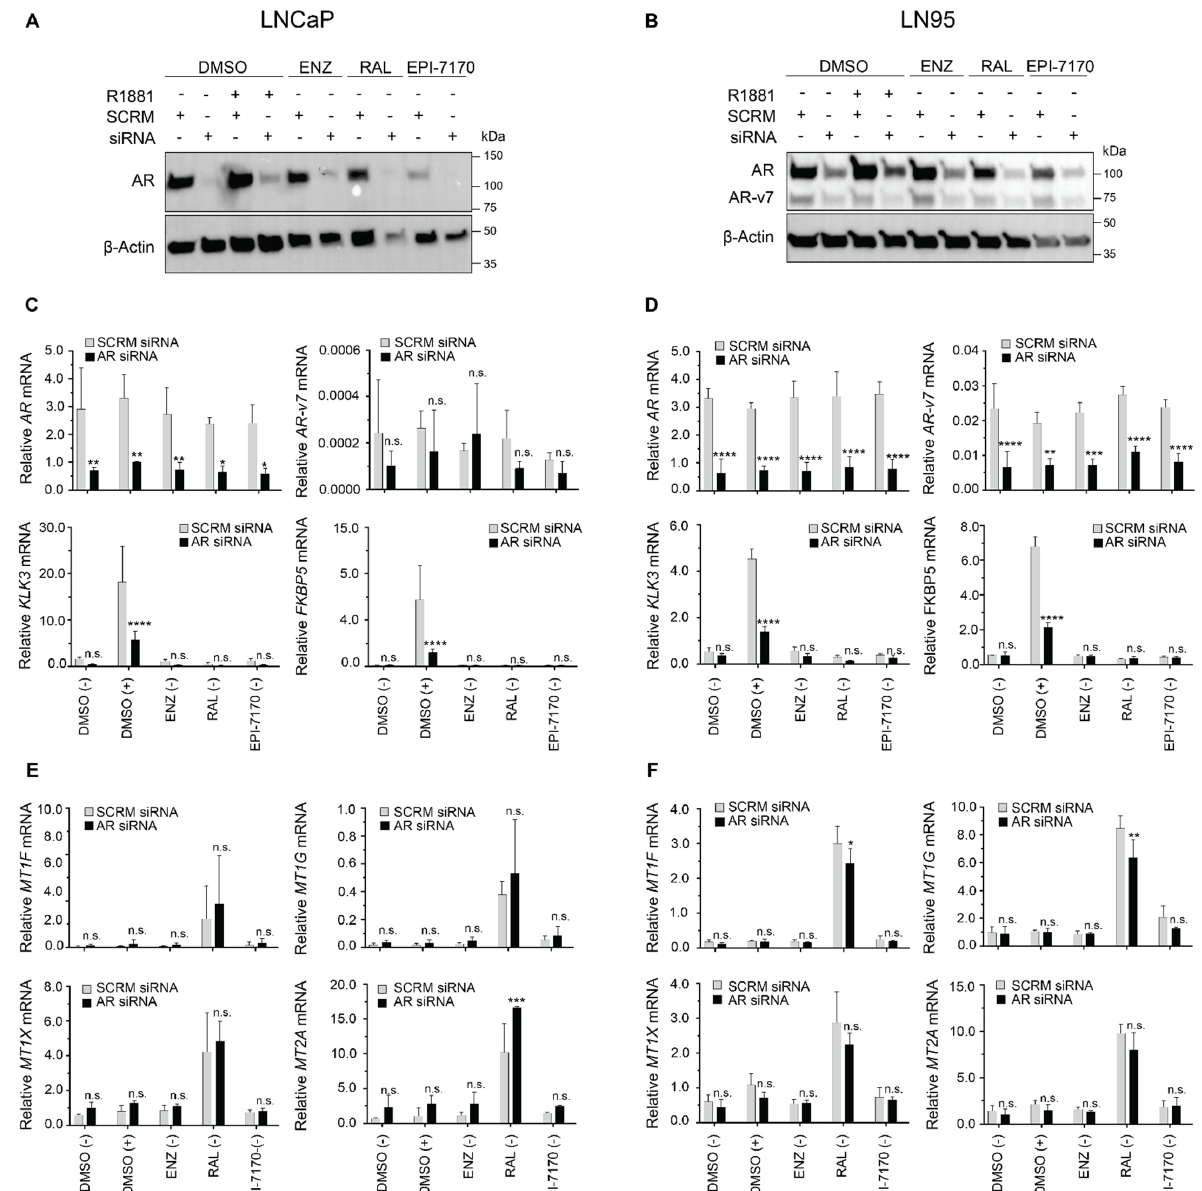
Figure 4. Ralaniten-induced expression of metallothionein is independent of levels of AR. ( A ) Western blot analyses of levels of AR proteins in LNCaP and ( B ) LN95 cells transfected with scramble (SCRM, control) or AR siRNA (10 nM) for 24 h and treated with DMSO, enzalutamide (5 µ M), ralaniten (35 µ M), or EPI-7170 (5 µ M) in the presence or absence of 1 nM R1881. The uncropped immunoblot images can be found in Figure S2. ( C ) Transcript levels of AR, AR-V7, KLK3, and FKBP5 were normalized to transcript levels of SDHA from LNCaP and ( D ) LN95 cells treated with DMSO, enzalutamide (5 µ M), ralaniten (35 µ M), or EPI-7170 (5 µ M) in the presence (+) or absence ( − ) of 1 nM R1881. ( E ) Transcript levels of MT1F , MT1G , MT1X, and MT2A were normalized to transcript levels of SDHA from LNCaP and ( F ) LN95 cells treated with DMSO, enzalutamide (5 µ M), ralaniten (35 µ M), or EPI-7170 (5 µ M) in the presence (+) or absence ( − ) of 1 nM R1881. Ralaniten induction of expression of metallothionein isoforms was generally not reduced or only modestly impacted by knockdown of AR. Data presented as mean ± SD and analyzed by two-way ANOVA with Sidak’s test applied post hoc ( n = 3 independent experiments). * p < 0.05; ** p < 0.01; *** p < 0.001; **** p < 0.0001; n.s., not significant. ENZ, enzalutamide; RAL, ralaniten; +, R1881; − ,